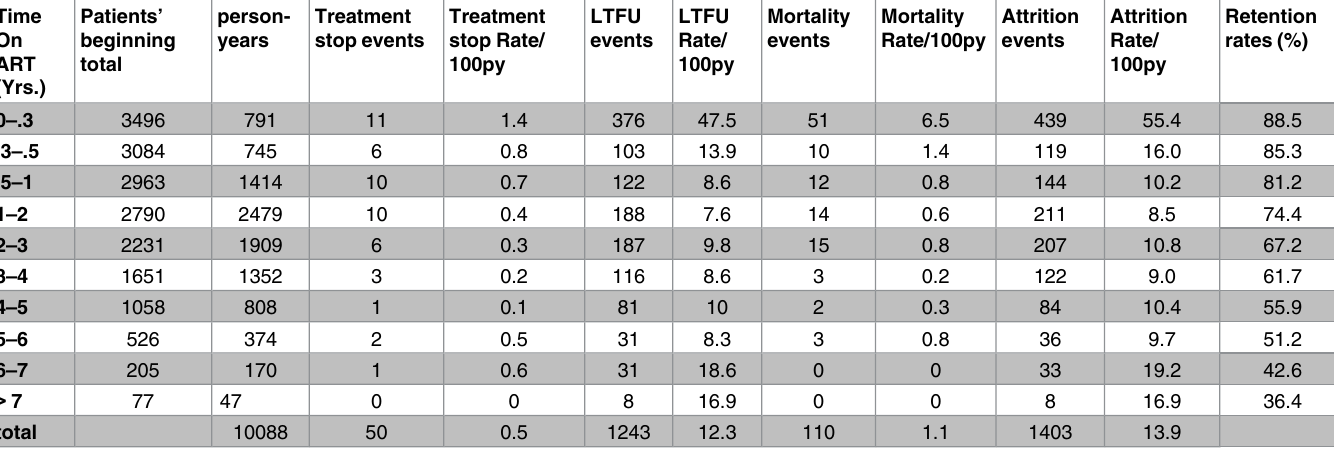
Table 2. Treatment stop, LTFU, Mortality, attrition and retention rates by time on ART. Time On ART